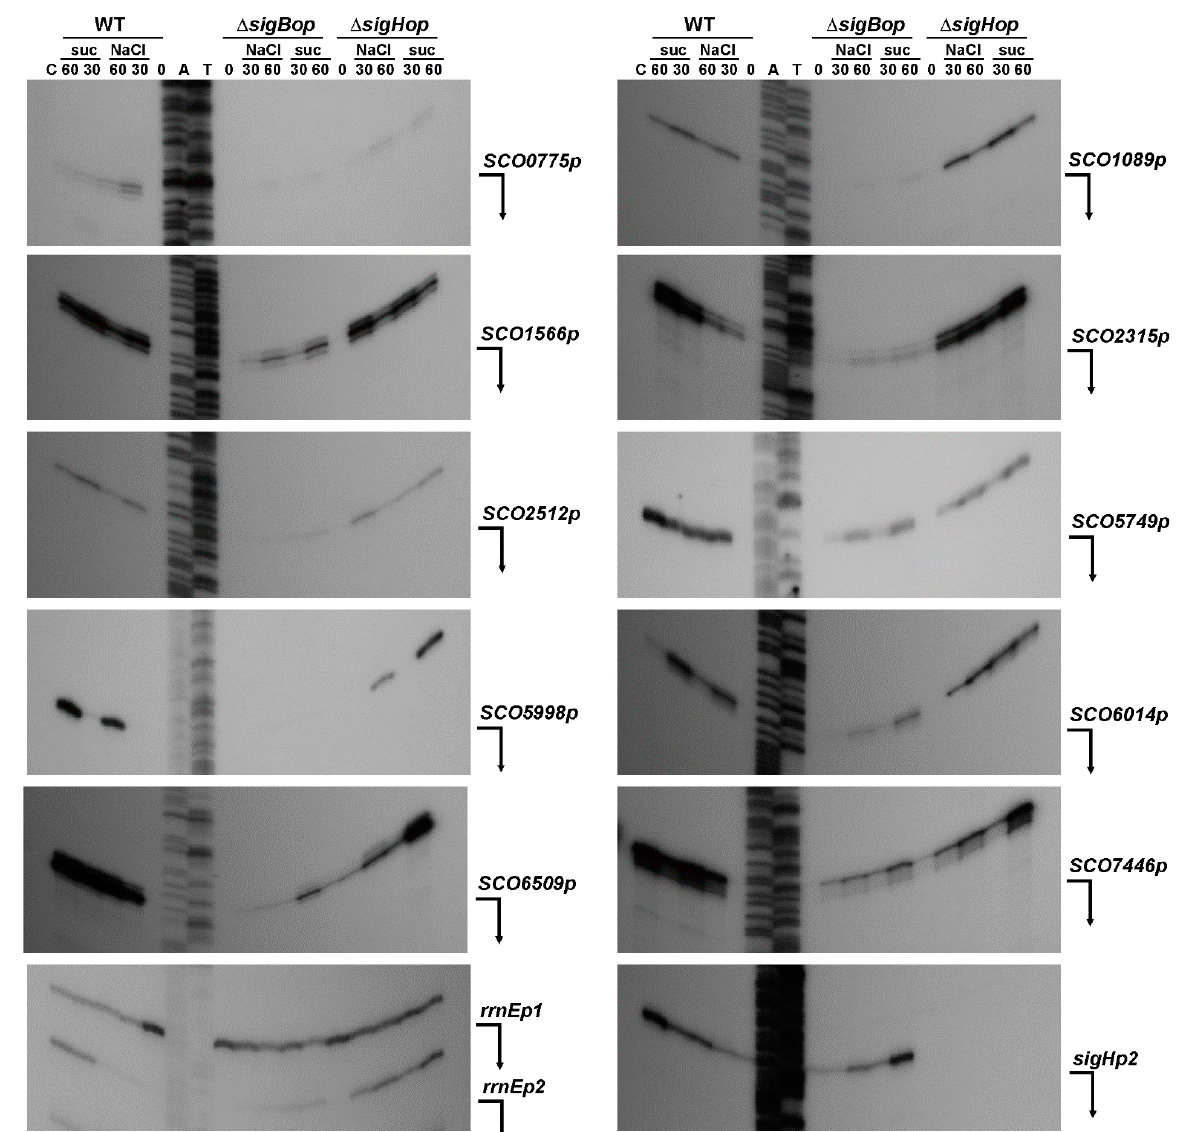
Figure 4. High-resolution S1-nuclease mapping of the TSS for the SigB-dependent promoters in S. coelicolor A3(2). The 5´-labeled DNA probes were hybridized with 40 µ g of RNA and treated with 120 U of S1-nuclease as described in the Materials and Methods. RNA was isolated from liquid cultured S. coelicolor M145 (WT) and its isogenic ∆ sigBop and ∆ sigHop mutants. The strains grew into the exponential phase (lane 0), then were exposed to osmotic stress conditions with 0.5 M NaCl and 1 M sucrose (suc) and RNA isolated after 30 or 60 min (lanes 30 or 60). E. coli tRNA was used as a control (lane C). Control S1-nuclease mapping was performed with the same RNA samples and a DNA probe for SigH-dependent sigHp2 promoter [27]. The RNA-protected DNA fragments were analyzed on DNA sequencing gels together with G + A (lane A), T + C (lane T) sequencing ladders derived from the end-labelled DNA fragments [46]. The bent arrows indicate positions of the protected fragments.